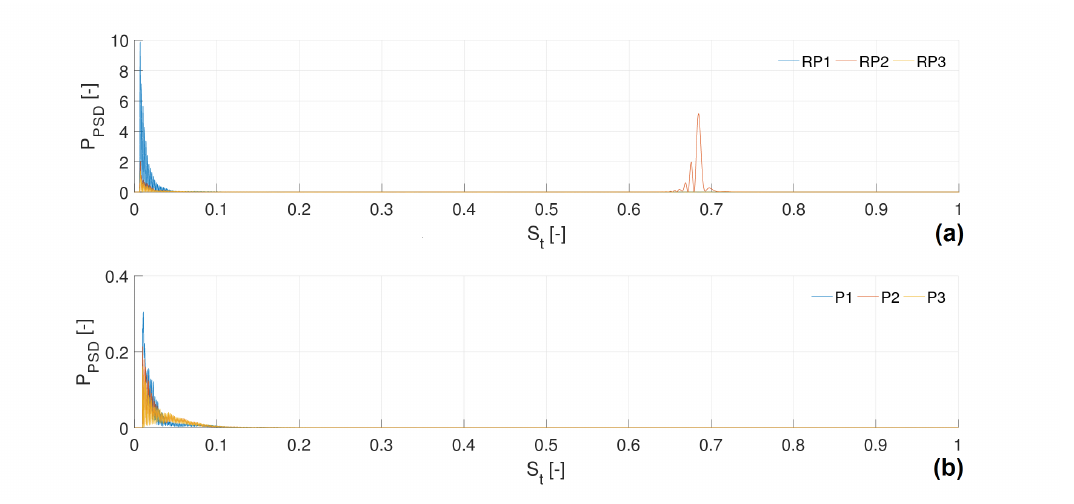
Figure 14. Normalized power-spectra of the pressure signals acquired from monitoring points in the draft tube. ( a ) Points in the straight cone; and ( b ) points in the elbow section.